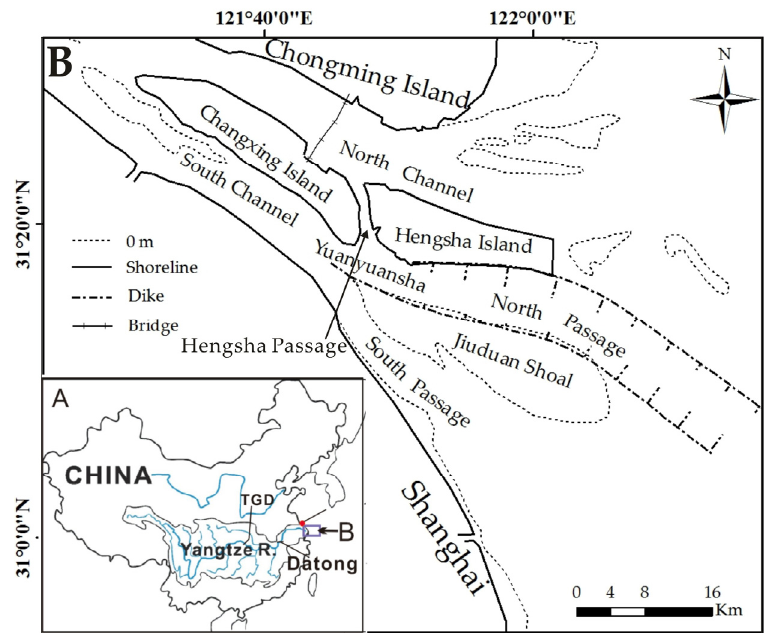
Figure 1. Geographical location of the study area—the Yangtze River estuary in China, with the Changxing Island, Hengsha Island, the North and South Channels and Passages, and the Jiuduansha Shoal wetland.